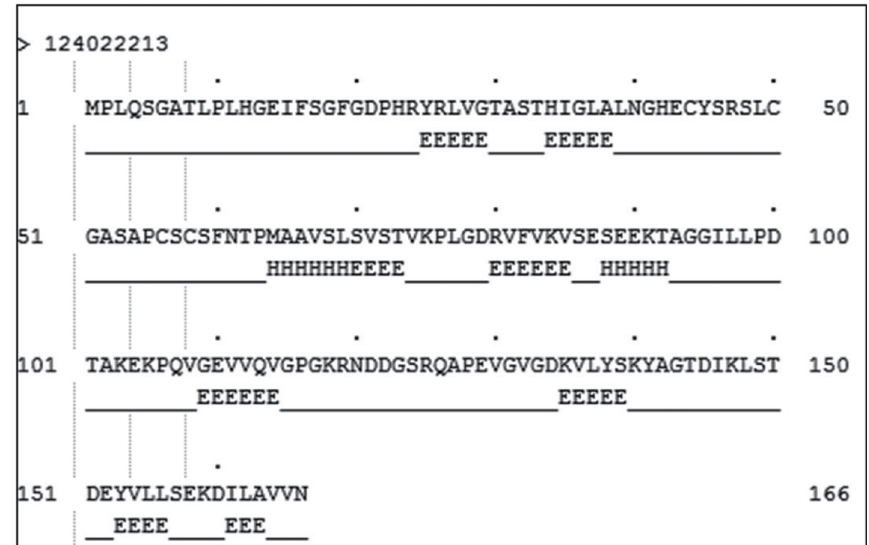
Figure 2: Secondary structure prediction for the protein P9303_05031. Secondary structure was predicted for all 166 amino acids present in the protein sequence. The Helical regions are shown as “ H ” , the coiled regions are shown as “–––” and the Sheets are shown as “ E ” .